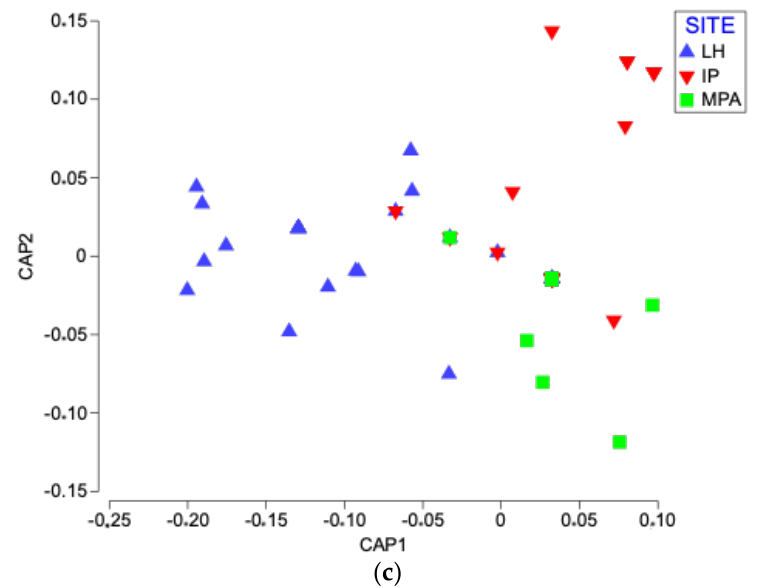
Figure 5. Canonical analysis of principal coordinates (CAP) illustrating the diversity of fungal communities ( a ) in solid sediment (SS); ( b ) watery sediment (WS), and ( c ) microplastics (MPs). In ( a , b ) symbols indicate Livorno harbor (LH), intermediate point (IP), and marine protected area (MPA), while colors indicate the different matrices within them.